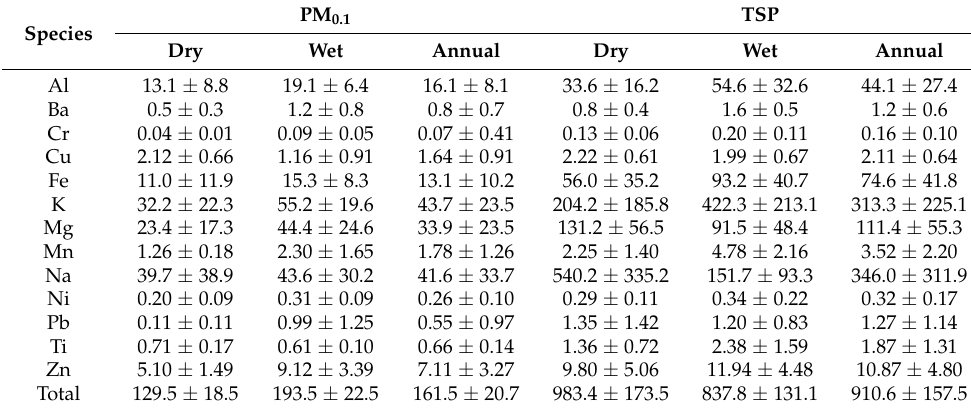
Table 4. Concentration of trace elements in Hat Yai, southern Thailand (ng/m 3